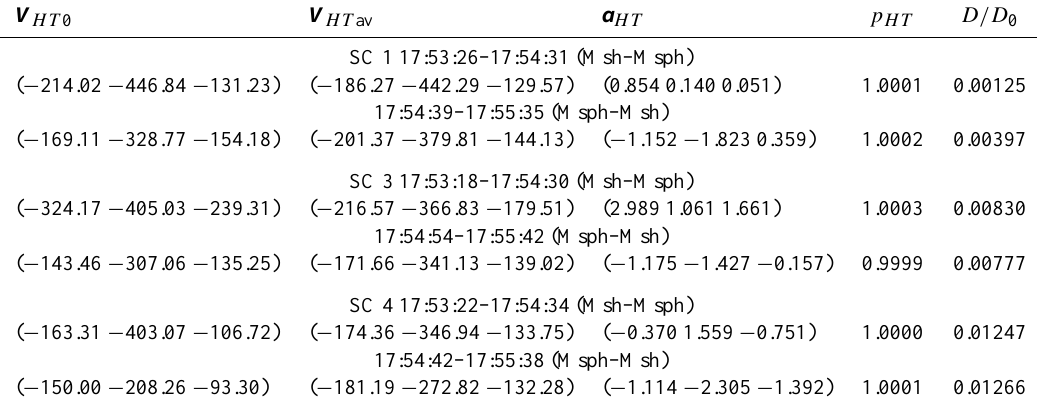
Table 1. dHT analysis results for the two consecutive magnetopause crossings discussed in detail in this section. Velocities are in km/s and acceleration in km/s 2 . All vectors are expressed in the GSE frame. The results presented here have been obtained by introducing a constant acceleration of the dHT frame: V HT = V HT 0 + a HT t . p HT is the fitting slope between E HT = − V HT × B and E C = − V × B , the convection electric field. D/D 0 is the least square quality factor. V HT av is the average velocity of the dHT frame. V HT 0 V HT av a HT p HT D/D